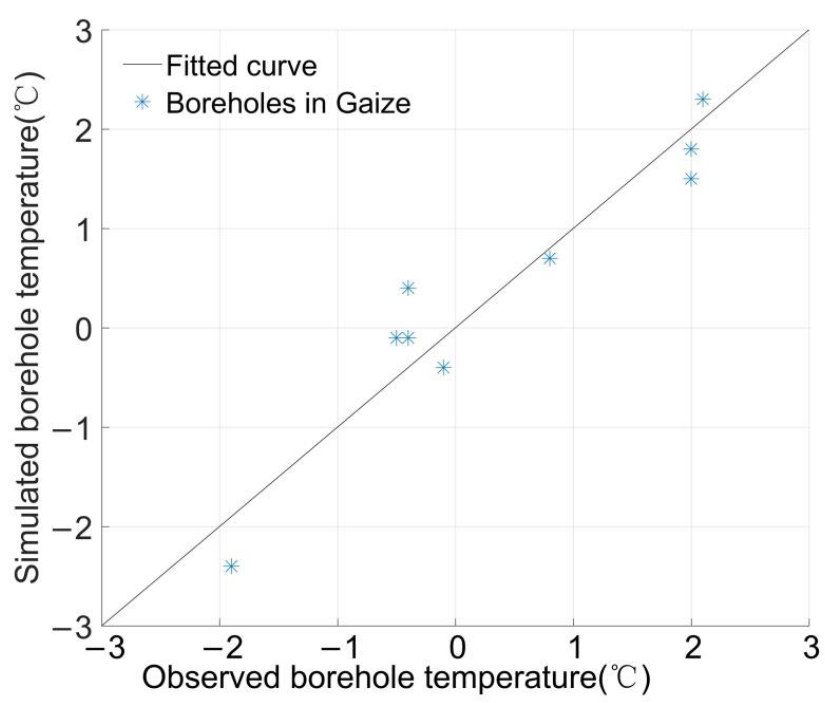
Figure 7. Plots of simulated and observed MAGT of nine boreholes in the Gaize area.